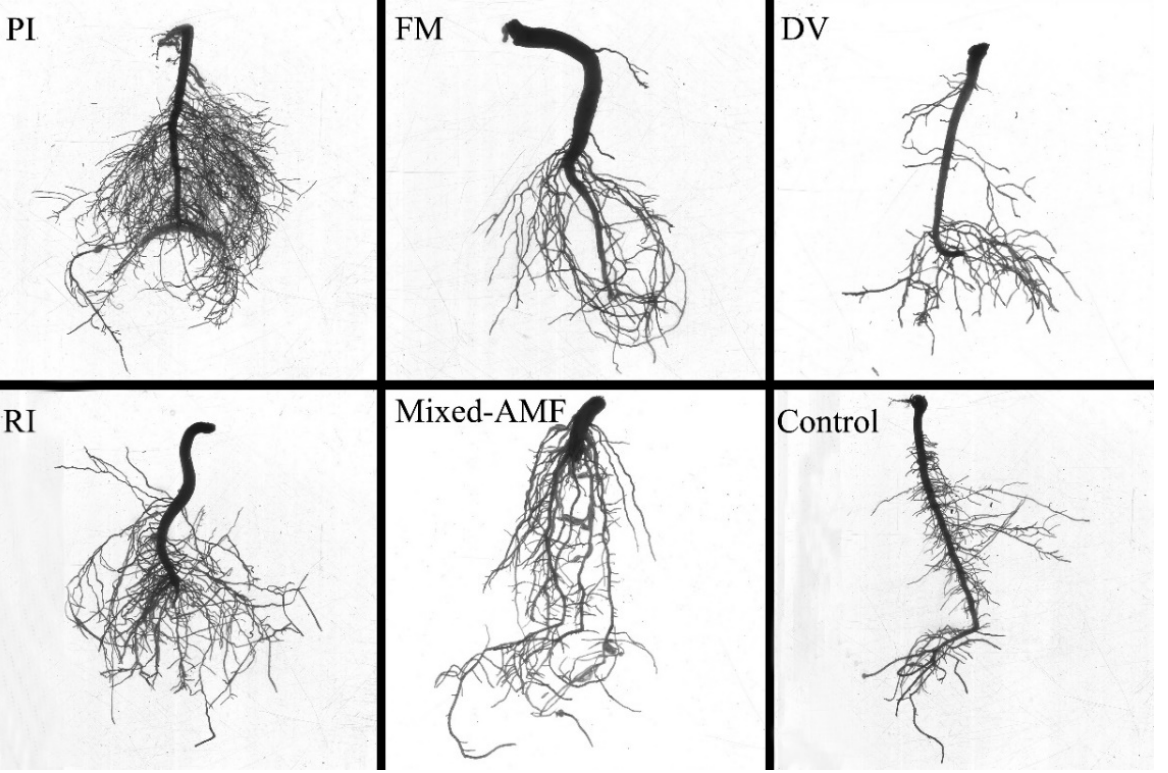
Figure 2. Changes in root architecture of Camellia oleifera plants after inoculation with symbiotic fungi. The abbreviation is the same as Table 2. Table 3. Effects of symbiotic fungi on root morphological parameters of Camellia oleifera plants.